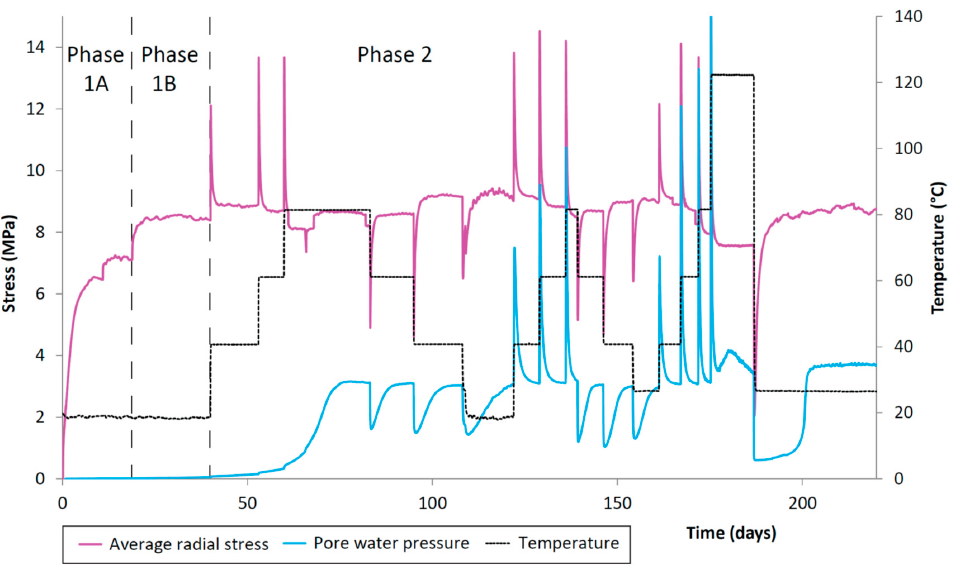
Figure 6. CVRF-1 test porewater pressure, recorded by the one porewater pressure transducer in the experimental oven located at the lengthways midplane of the sample. Temperature (black dotted line) and average radial stress (pink line) are shown. Testing phases are denoted by the vertical dashed lines. Increases in radial porewater pressure correlate with the increases in temperature.